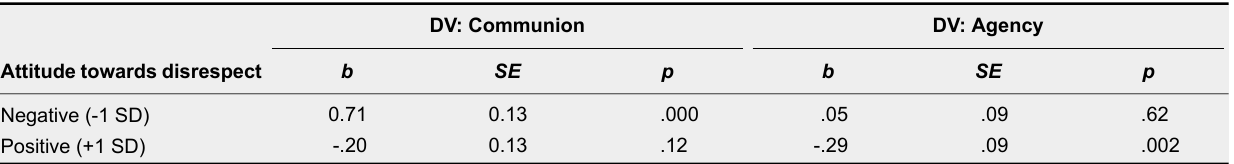
Simple Slope Analysis of the Interaction Effect of Disrespectful (Steinbrück) vs. Respectful (Merkel) Candidate Behavior a and Voters’ Attitude Towards Disrespect in Politics on the Two Dimensions of Social Judgment in Study 2